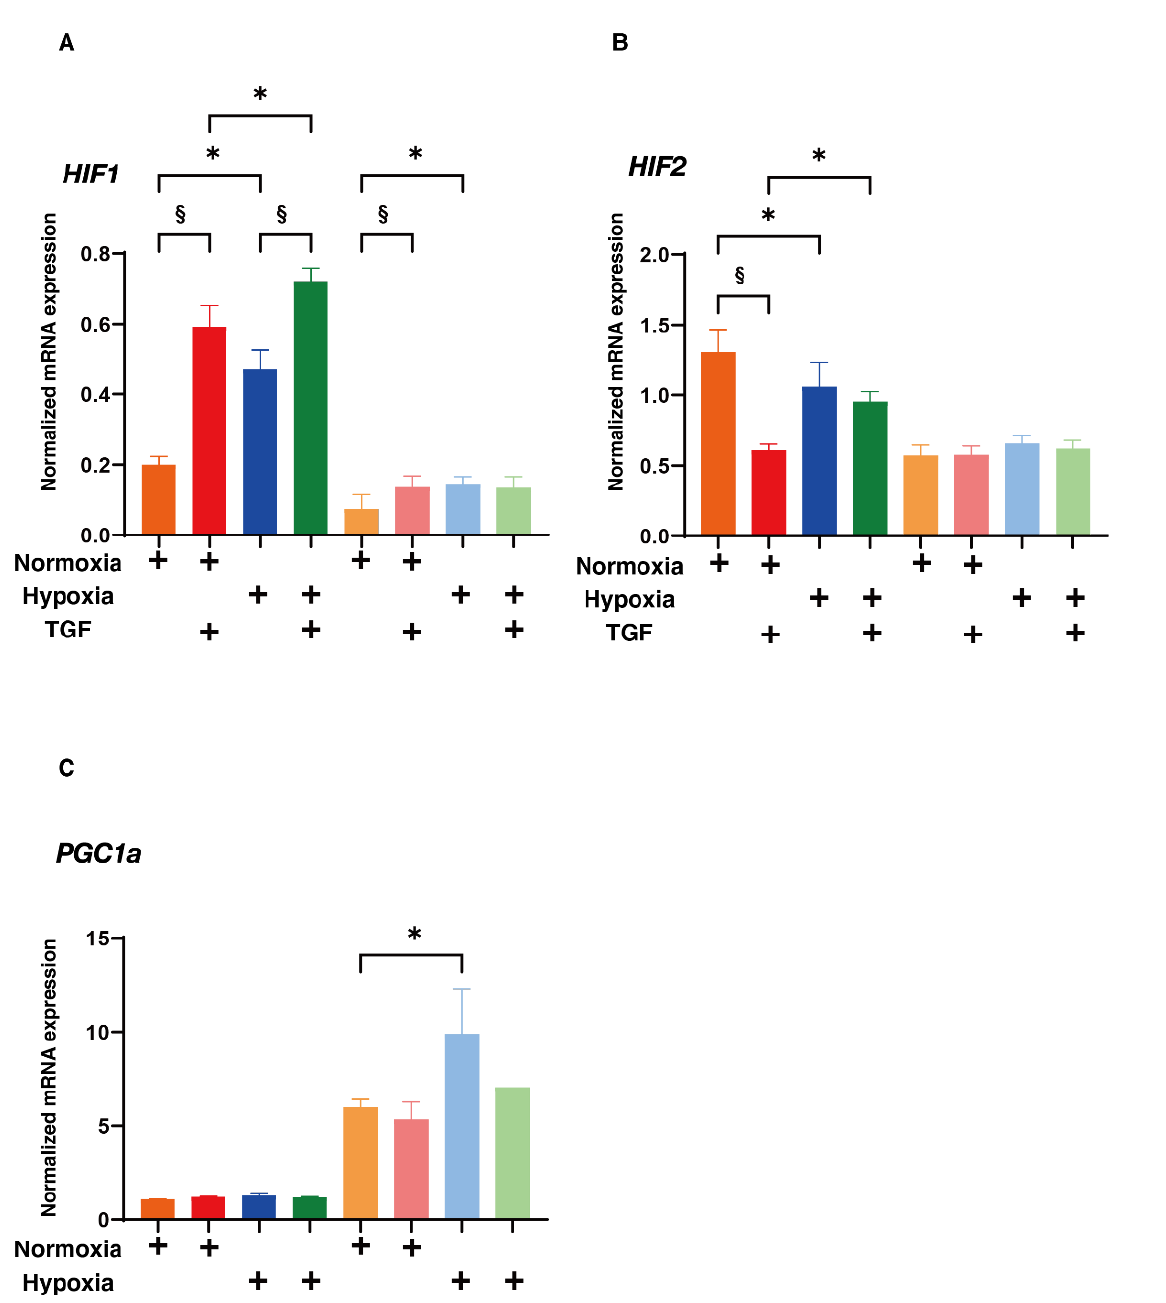
iments (2D; n = 5, 3D; n = 3). Data are presented as the mean ± the standard error of the mean (SEM).